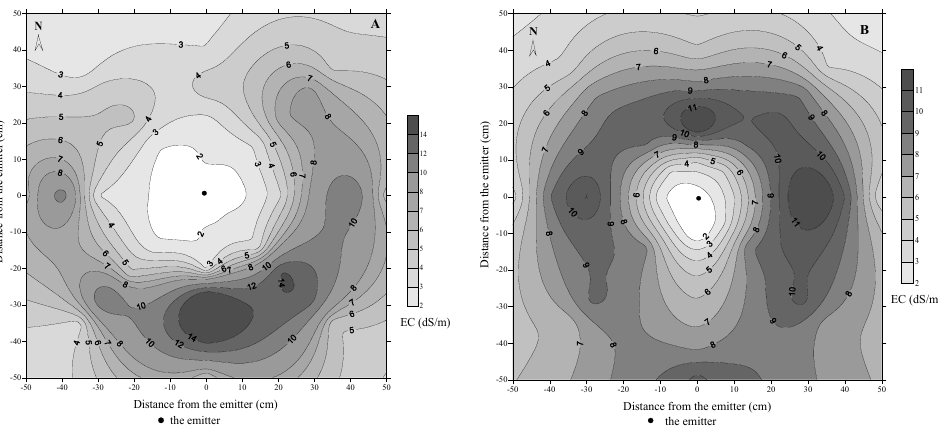
Figure 5. Spatial distributions of soil salt crust EC values around the emitters at ( A ) the flat sandy land; and ( B ) the south-facing dune slopes with angles of 15°–25°.